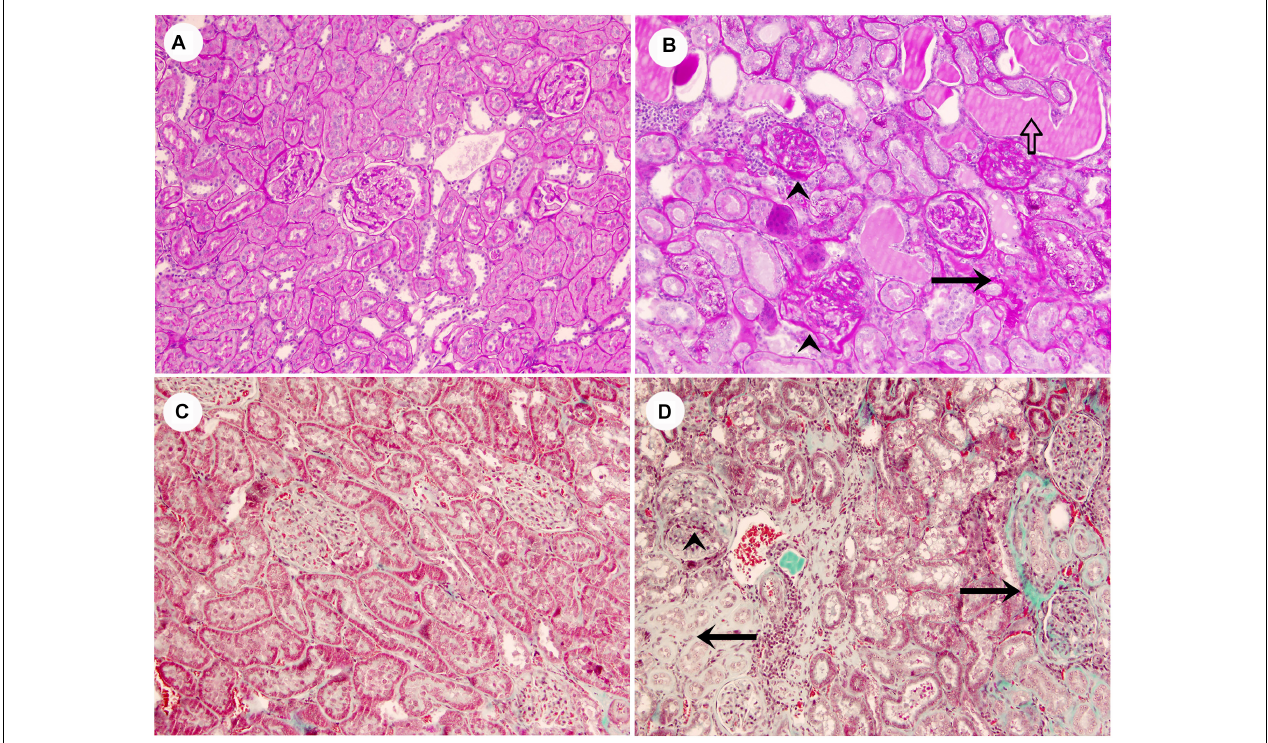
FIGURE 1 | Representative images of lean rats without glomerular or tubulointerstitial injury (A,C) , and obese rats with segmental glomerular sclerosis (ˆ), tubular atrophy (black arrows), tubular casts (white arrow) and inflammatory infiltrate (B,D) ( A,B , PAS stain; C,D , Masson’s trichrome stain, original magnification 10 × ).